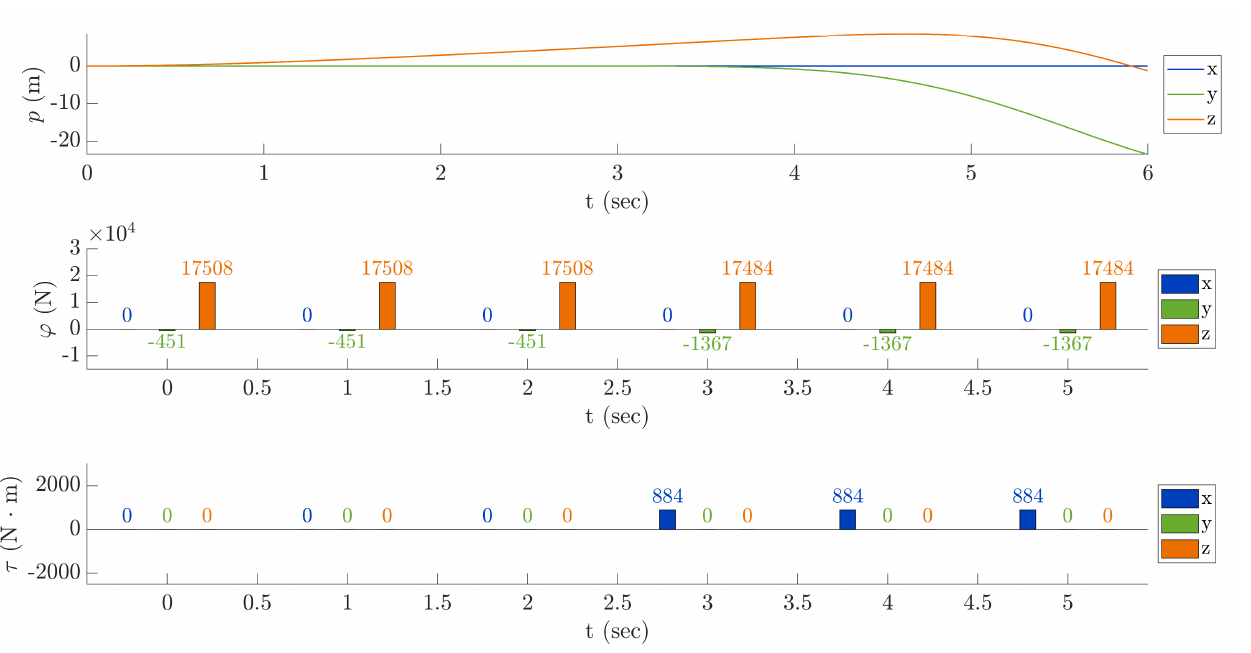
Figure 15. Fifth test—positive roll